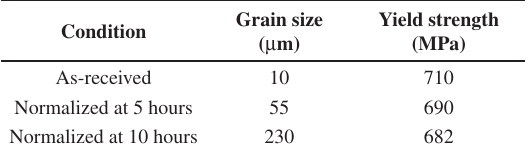
Table 3. Yield strength calculated for the HAZ normalized at 1200 °C with different grain